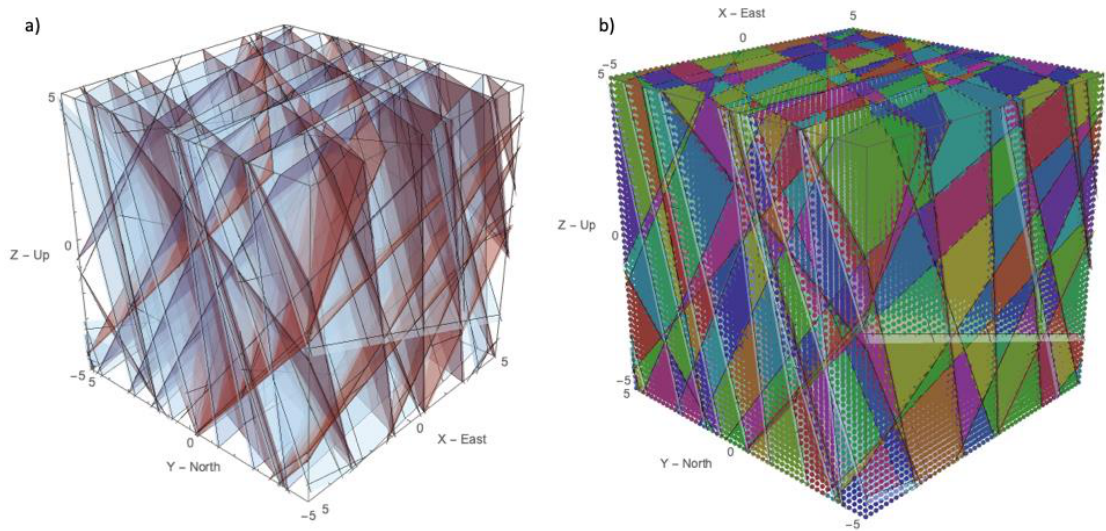
Figure 5. View of one realization of the 10 m × 10 m × 10 m persistent discrete fracture network (DFN) built for the Tornado Mountain site ( a ) and discrete blocks defined by the DFN, colorized randomly ( b ). Modeled after the work in [35].